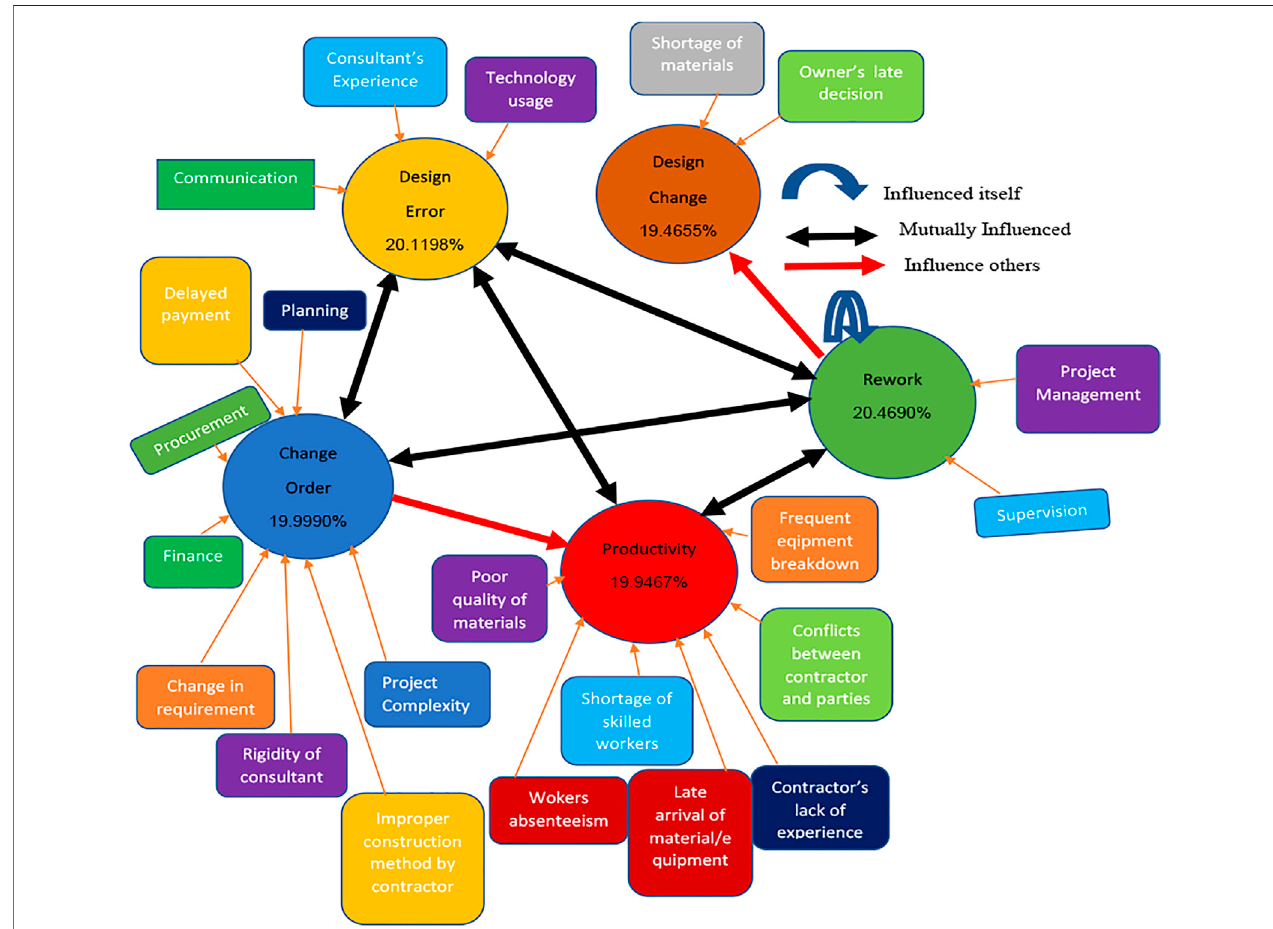
FIGURE 2 | DEMATEL analysis